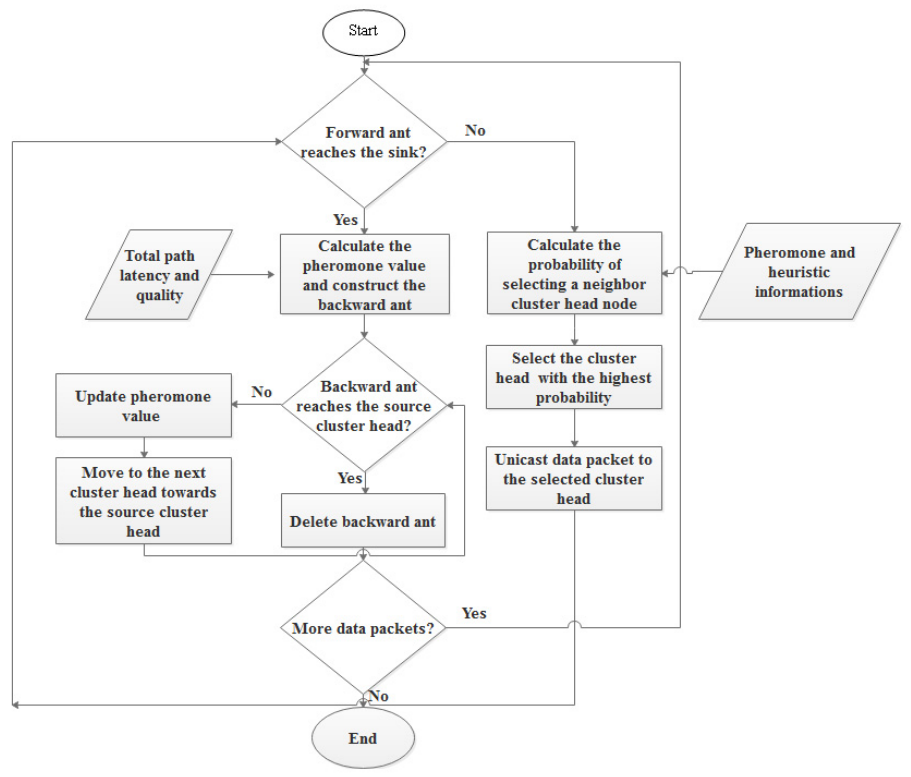
Figure 5. The proposed routing algorithm flowchart.